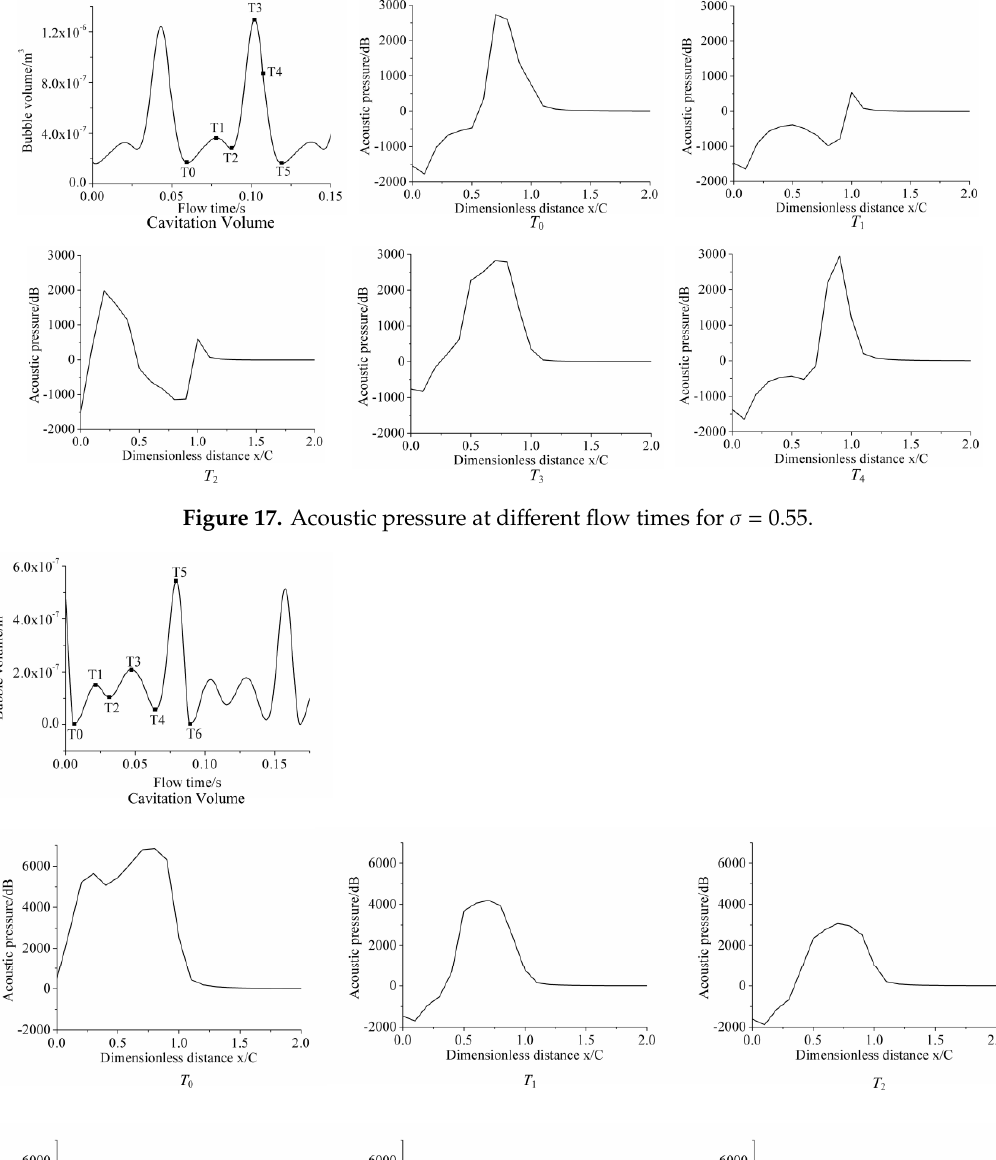
Figure 19. Pressure pulsation at U7, U8, U9, and U10 for σ = 0.65. Figures of acoustic power spectral density (PSD) of three different cavitation numbers are presented. Note that the same position was selected in different conditions. When σ = 0.55, the frequency of the second peak, which represents the growth and collapsing of front bubbles, was about twice as much as that of the first peak, which represents the growth and collapse of the trailing vortex. To be specific, the growth and collapsing of the trailing vortex occurred once a cycle, but that of the front bubbles happened twice in one cycle. When σ = 0.65, the frequency and magnitude of the first and second peak were almost the same as that of σ = 0.55. When σ = 0.75, a difference can be observed that the frequency of the second peak was three times higher than that of the first peak, and that means the growth and collapsing of leading-edge